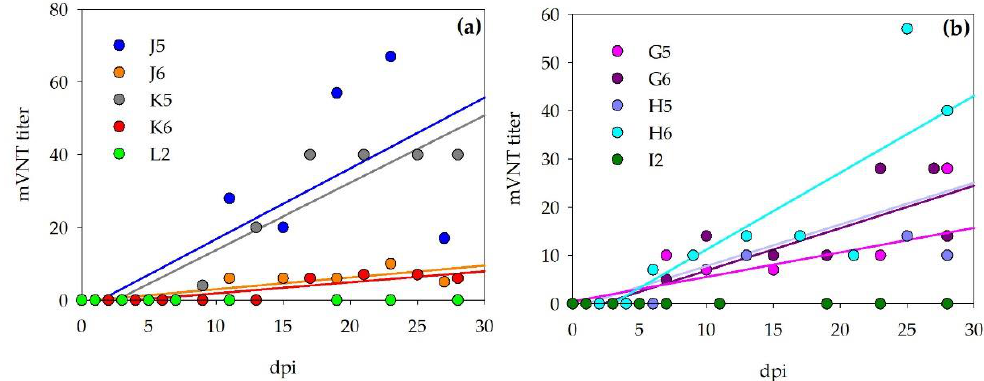
Figure 6. Micro-virus neutralization test (mVNT) results for inoculated cattle ( a ) and sheep ( b ). mVNT titers during the observation period are visualized and show a steady increase in neutralizing antibodies for the inoculated ruminants (visualized by linear regression of mVNT titers; calculations done by Sigmaplot), whereas the control animals did not develop neutralizing antibodies.